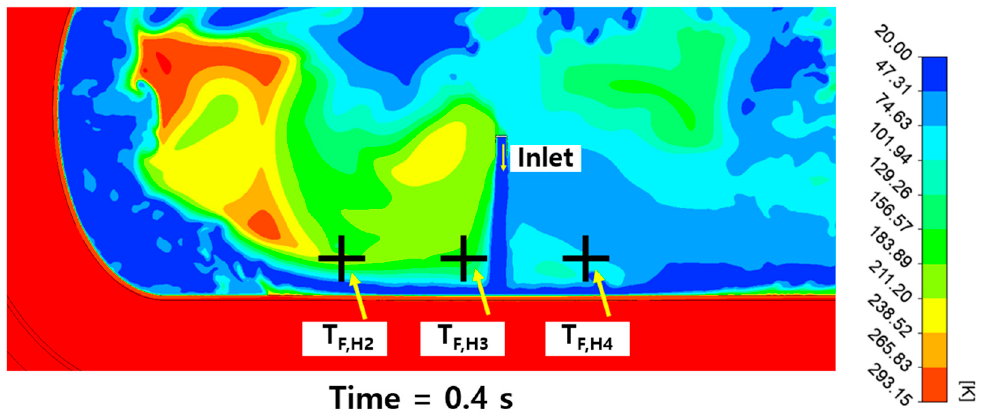
Figure 14. Distributions of the temperature at the horizontal temperature points of 2, 3, and 4.